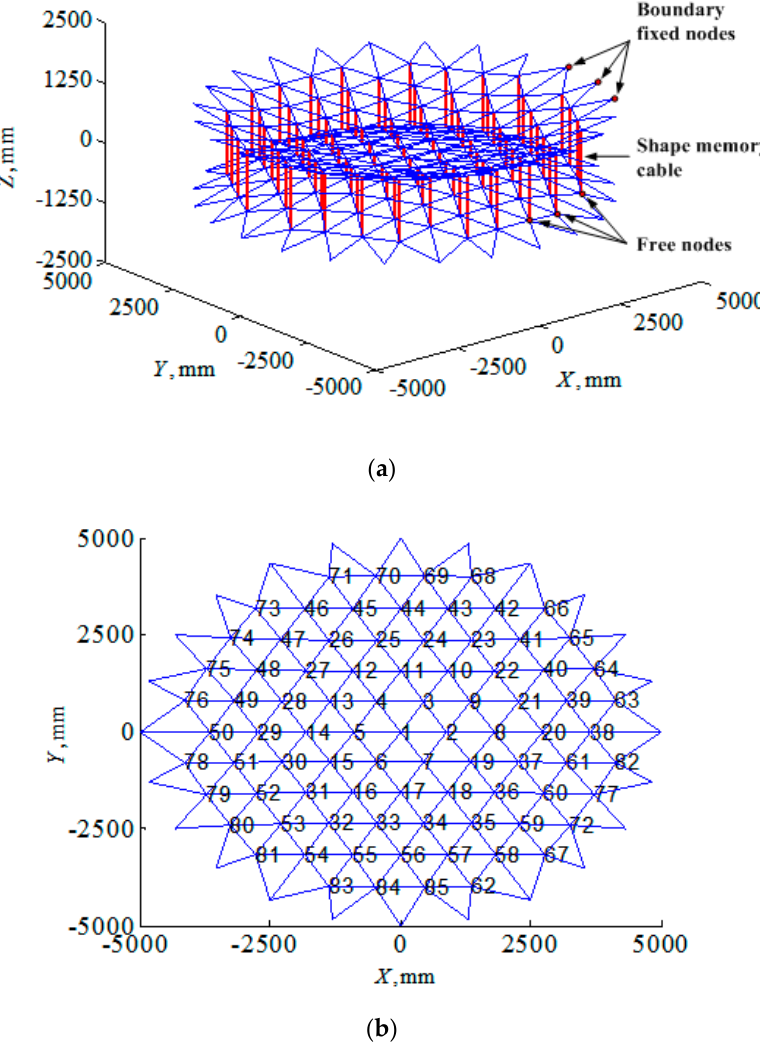
Figure 4. SMC in the deployable state in this work: ( a ) Isometric view and ( b ) free nodes numbering of the front reflector surface.